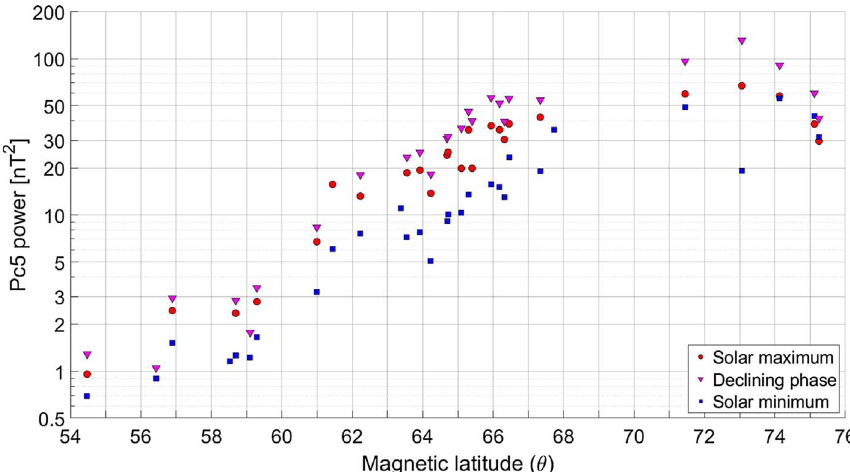
Fig. 4. Mean ULF power in all IMAGE stations for solar maximum (red), declining phase (purple) and solar minimum (blue).